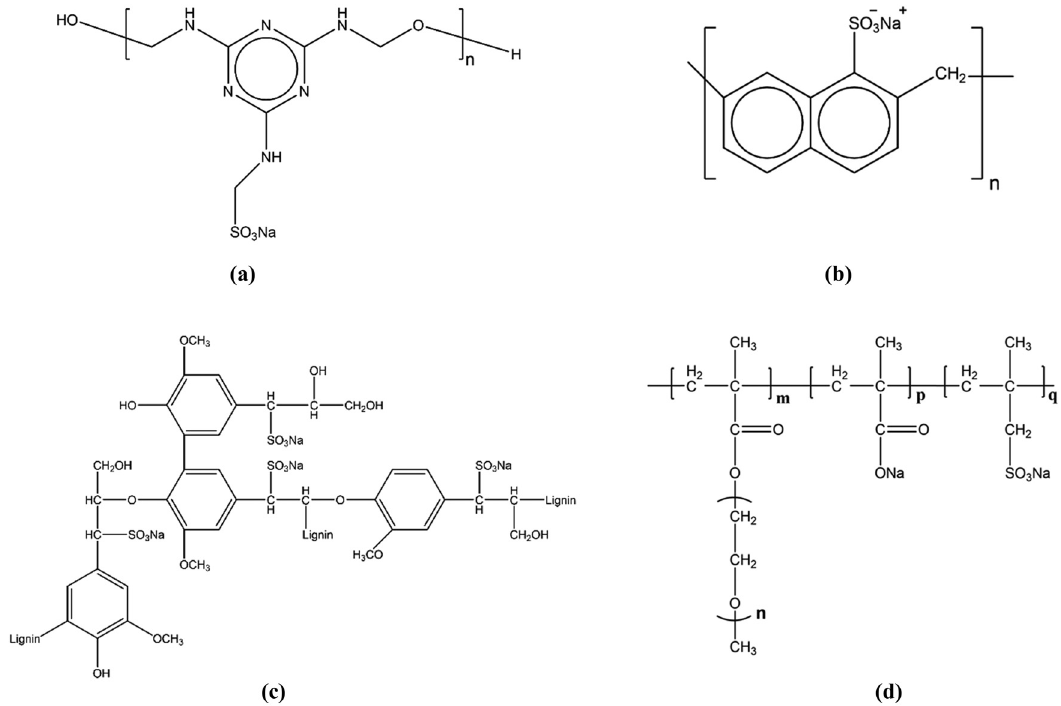
Figure 13: General structure of ( a ) sulfonated melamine formaldehyde polycondensates; ( b ) chemical structure of sulfonated naphthalene - formaldehyde condensates; ( c ) schematic drawing of the main building blocks of the lignosulfonate molecule; and ( d ) chemical structure of the polycarboxylate